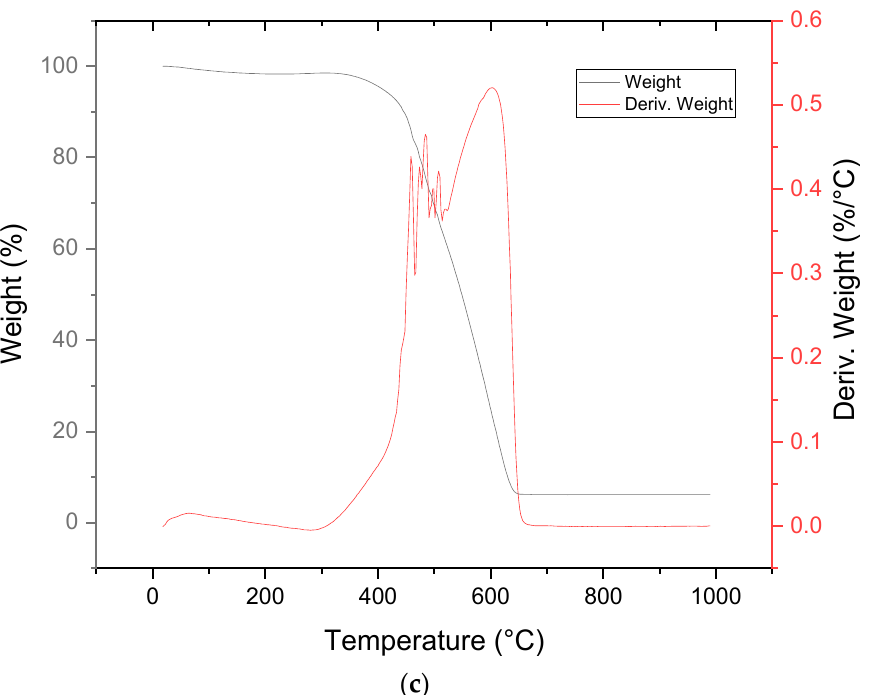
Figure 5. TGA/DTG graphs for ( a ) raw miscanthus, ( b ) SP-400-30, ( c ) PCI coal. Figure 6 shows the 3D FTIR images with respect to wavenumber, absorbance, and time for the raw miscanthus, pyro-biocarbon and PCI coal samples, respectively. The main peaks observed in the figure are mainly between 2402–2240 cm − 1 and 736–605 cm − 1 , showing the release of CO 2 and CO, respectively, during the combustion process, indicating the presence of C=O bonding. The peaks at wavenumber 2402–2240 are much more prevalent in the pyro-biocarbon and PCI samples relative to the raw sample; however, the raw sample contains additional peaks. For the raw sample, a weak stretch in the 4000–3500 wavenumber region indicates the presence of OH groups, and vibrations in the 1650–1450 wavenumber region are indicative of C=C aromatic rings. These peaks are no longer visible in the pyro-biocarbon sample, as the high-temperature thermal treatment removes some of the functional groupings. Since the samples were oven dried prior to FTIR analysis, the release of water vapor was not